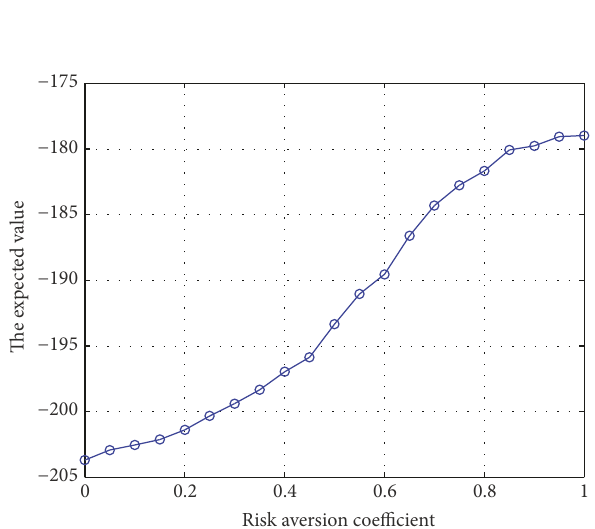
Figure 6: The expected value for different risk-aversion coefficient 𝜆 .